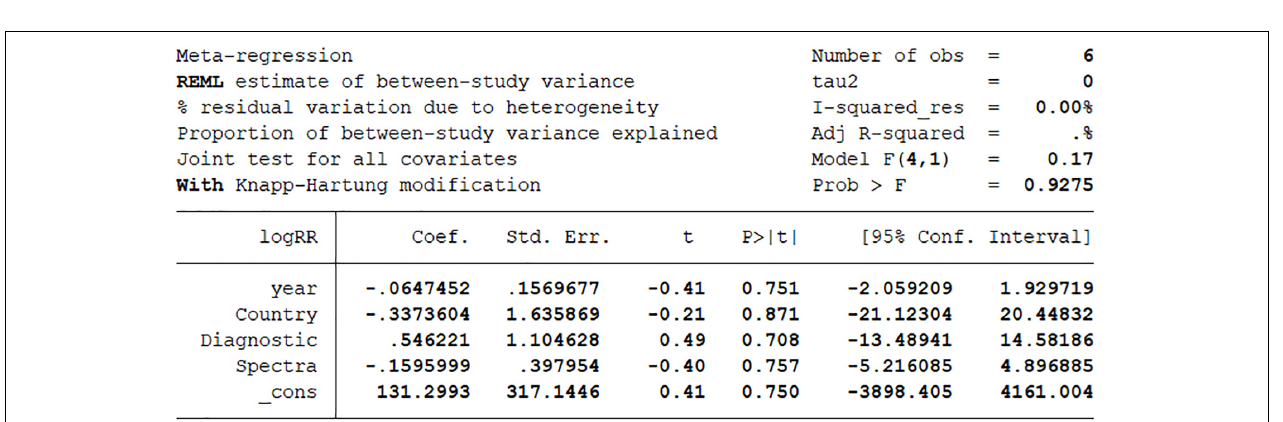
FIGURE 5 | The pooled date analysis of Raman spectroscopy (RS) in uterine cervical tumors in vitro group. (A) The forest plot of pooled sensitivity and specificity of Raman spectroscopy to diagnose uterine cervical tumors of four studies. (B) The pooled PLR and NLR of Raman spectroscopy in diagnosis of uterine cervical tumors. PLR, positive likelihood ratios; NLR, negative likelihood ratios. (C) The SROC curve of Raman spectroscopy in diagnosis of uterine cervical tumors. SROC, summary receiver operator characteristics.